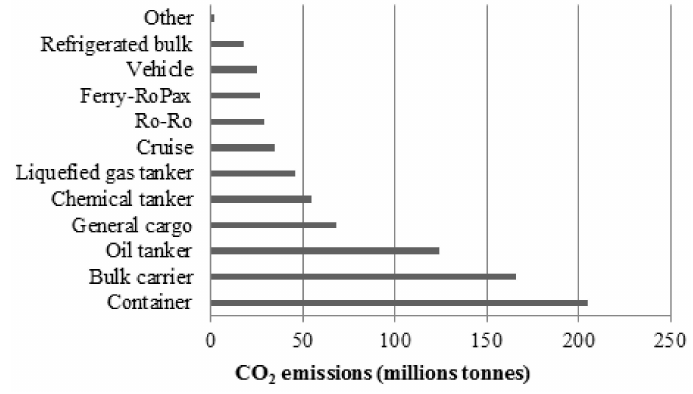
Figure 1. CO 2 emissions in 2012 adapted by the IMO study